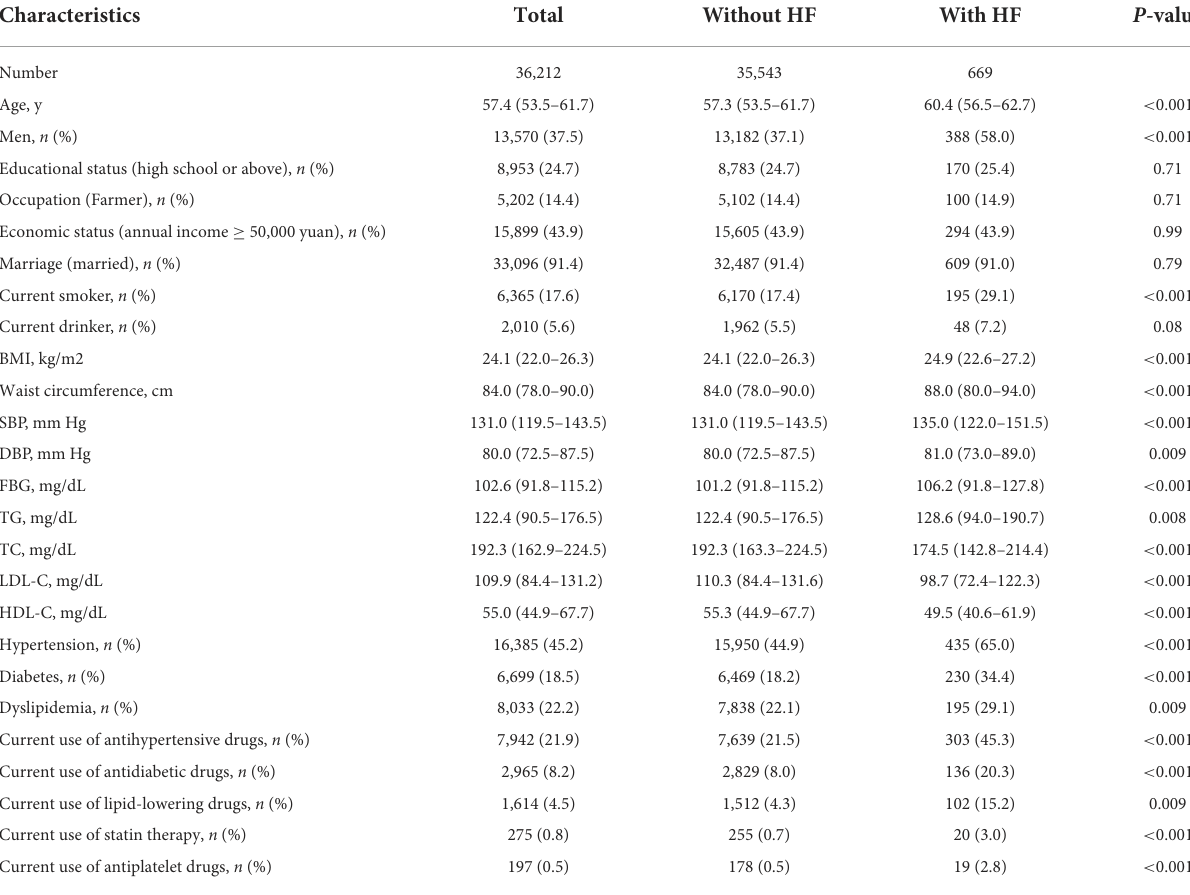
TABLE 2 Characteristics of study participants with or without hospitalization for heart failure among 36,121 participants.